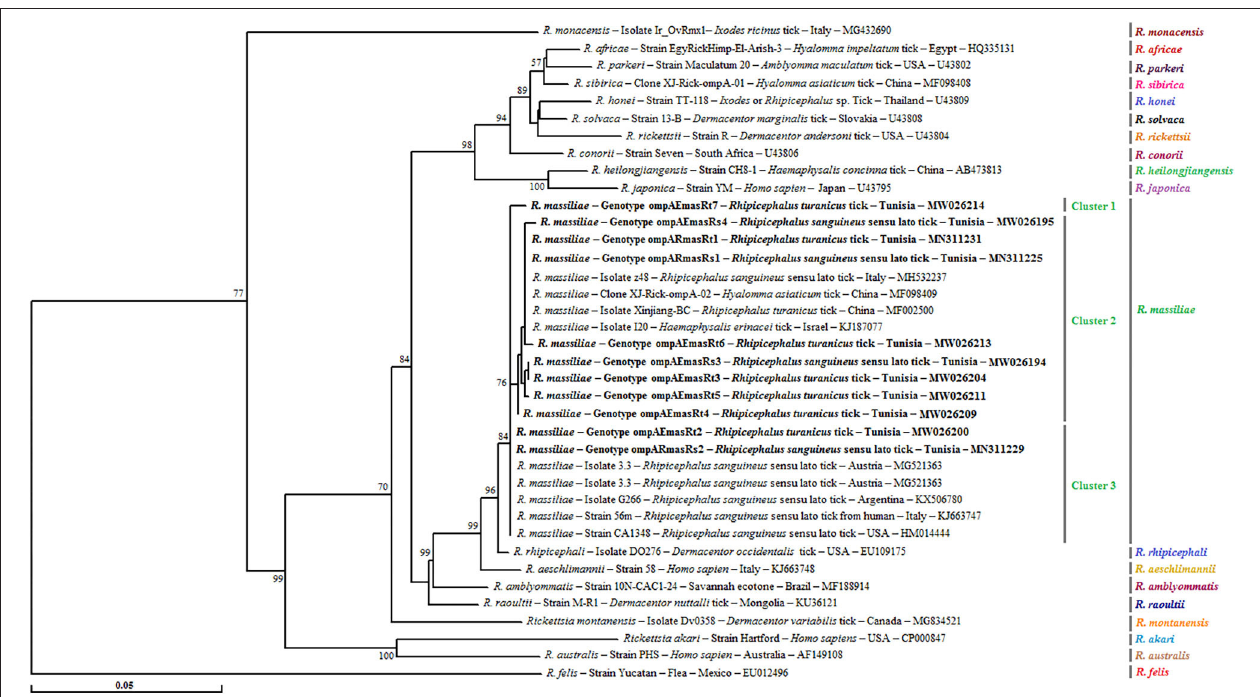
FIGURE 3 | Phylogenetic tree of Rickettsia species inferred with partial sequences (490 bp) of the ompA gene using the neighbor-joining method showing the novel obtained sequences ( n = 11) from Tunisian small ruminant ticks. Bootstrap values (1,000 replicates) are indicated in each node (only percentages > 50% are shown). The 11 genotypes of Rickettsia spp. obtained in the present study are indicated in bold. The host or vector, the genotype, strain or isolate name, the country of origin, and the GenBank accession number are represented. One R. felis ompA partial sequence was added as an